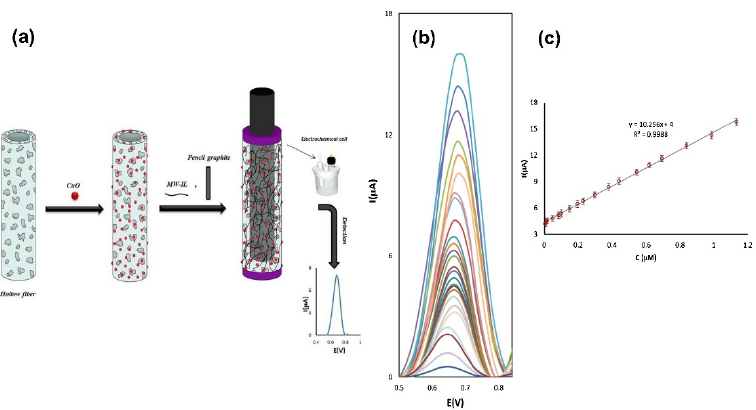
Figure 19. ( a ) Schematic illustration of the extraction and in-situ electrochemical detection of GLYP ( b ) Differential pulse voltammetry for GLYP, 0.1 M PBS (pH 7), ( c ) Linear dependence of peak currents on GLYP concentrations as a calibration curve. Reprinted with permission from [160]. Copy- right 2018 Elsevier.